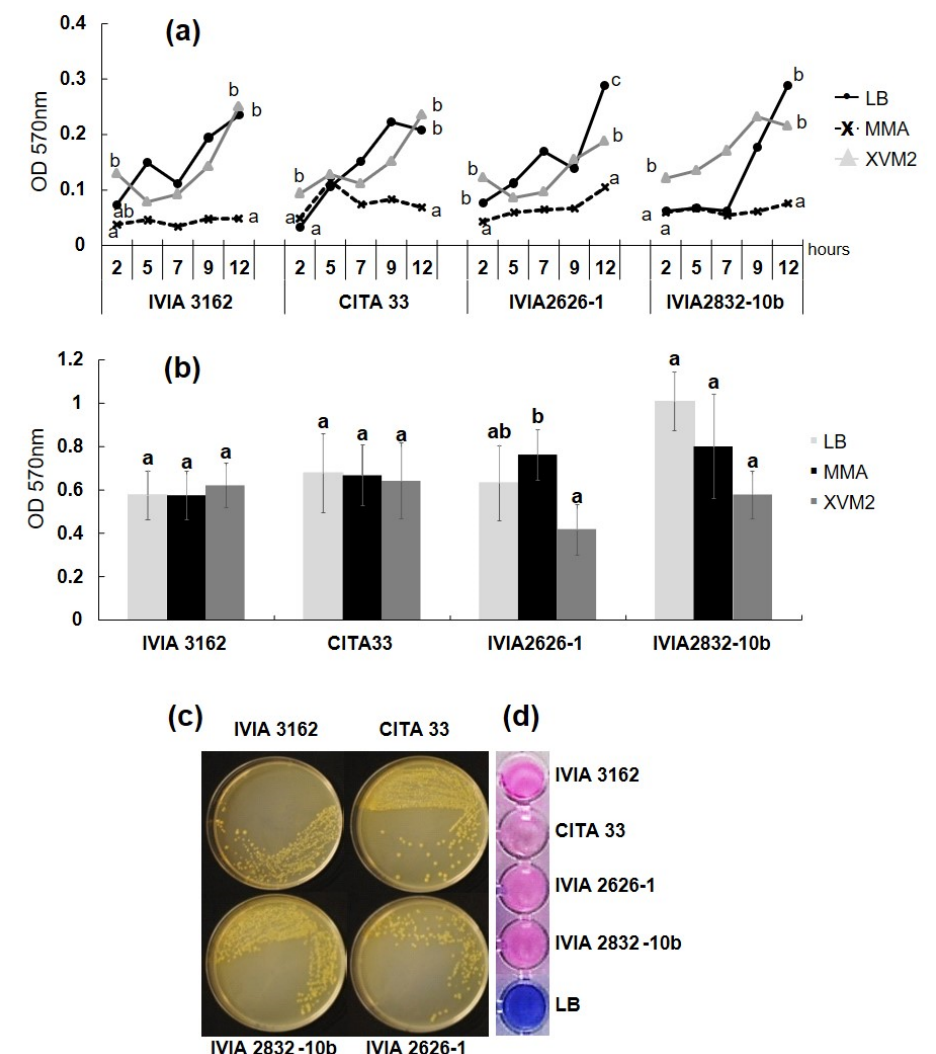
Figure 2. ( a ) Biofilm formation by Xap on polypropylene surface quantified by absorbance (570 nm) of crystal violet stain. Biofilm recorded at different growth times (from 2 to 12 h) in LB, MMA and XVM2 media after 72 h in static and dry condition (72 h incubation with no culture medium). ( b ) Biofilm recorded at 144 h of Xap growth and quantified in LB, MMA and XVM2 at 570 nm. ( c ) Bacterial colonies resulted from cells recovered from 48 h mature biofilm on LB. ( d ) Detection of cellular respiration with alamarBlue reagent of different Xap strains and negative control (LB). Blue color denotes no viable cells and pink color viable cells. Means with the same letter within the same time ( a ) or strain ( b ) do no differ significantly ( p < 0.05).